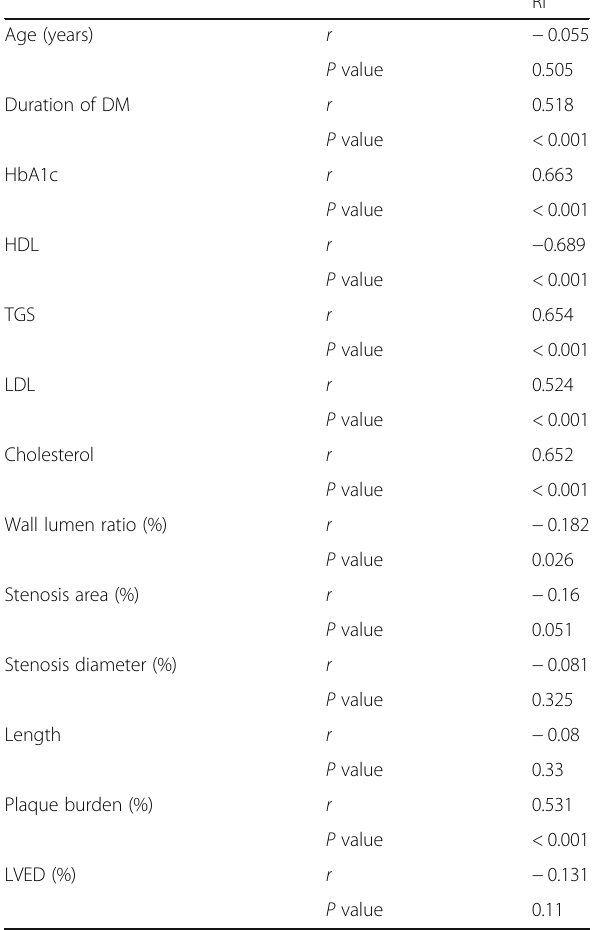
Table 1 Correlation analysis for remodeling index